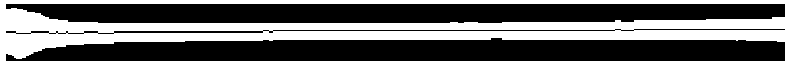
Figure 13. The center graph of the light stripe extracted by the proposed algorithm.